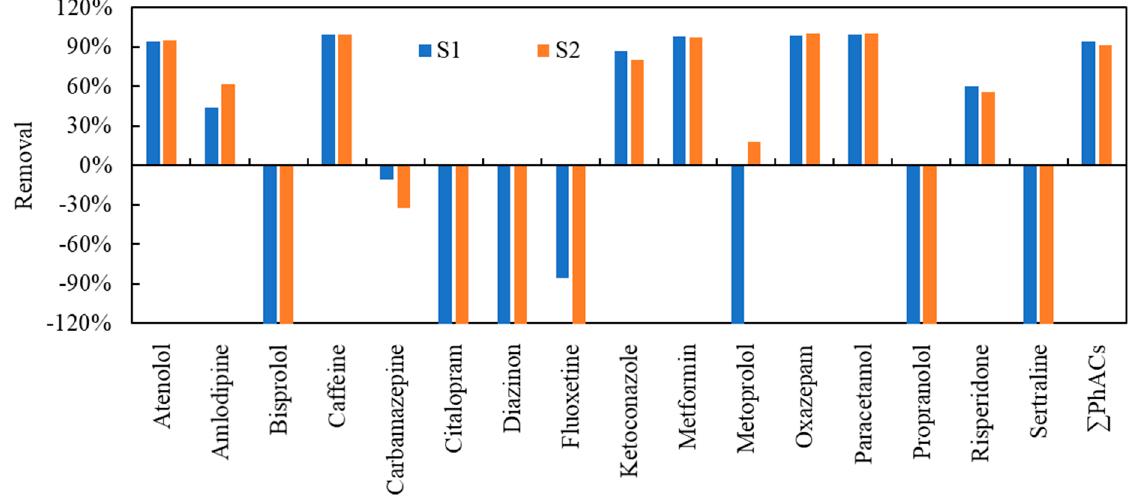
Figure 3. Efficiency (%) of Assamra wastewater treatment plant in removing pharmaceutically active compounds (PhACs, excluding antibiotics) from the wastewater. S1, S2 = parallel samples.